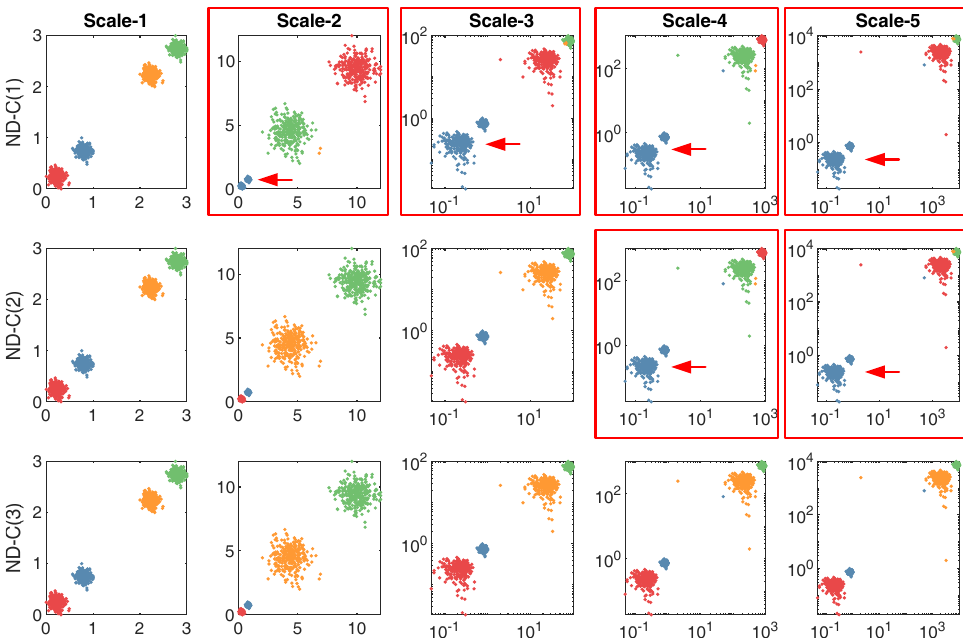
Figure 12. Comparison of the clustering results of ND-C(1), ND-C(2), and ND-C(3) on the first five scale-different datasets (Scale-1, Scale-2, . . . , Scale-5) shown in Figure 10. The red rectangles mark the sub-plots with false clustering assignments (pointed by the red arrows).